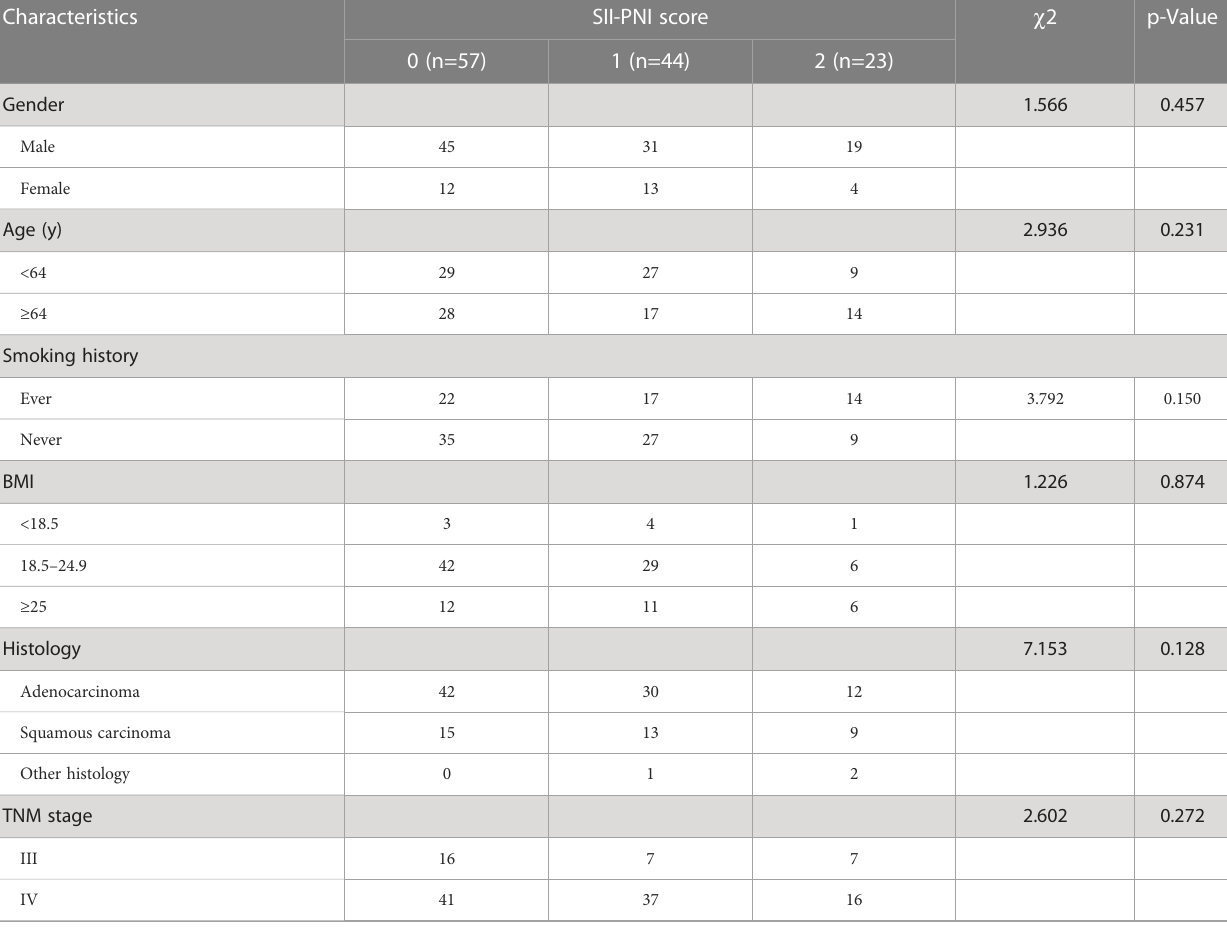
TABLE 2 The clinicopathological characteristics according to SII-PNI scores.